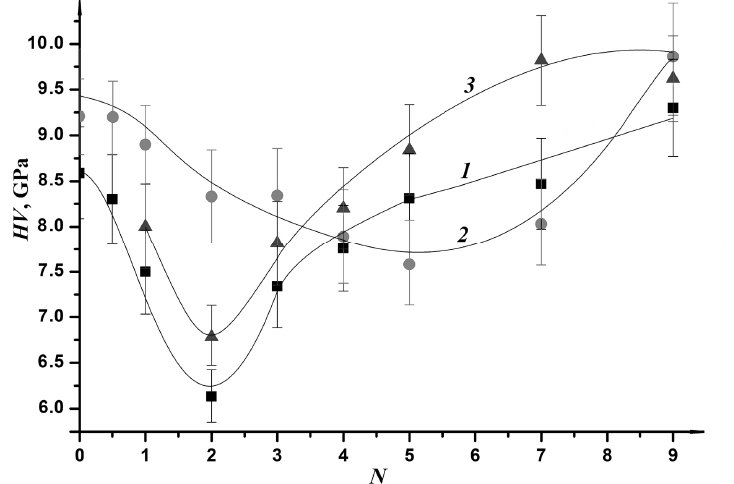
Figure 8. Microhardness of the materials as a function of number of revolutions upon HPT: 1 –Fe 53.3 Ni 26.5 B 20.2 AA; 2 –Co 28.2 Fe 38.9 Cr 15.4 Si 0.3 B 17.2 AA; 3 –composite formed from di ff erent